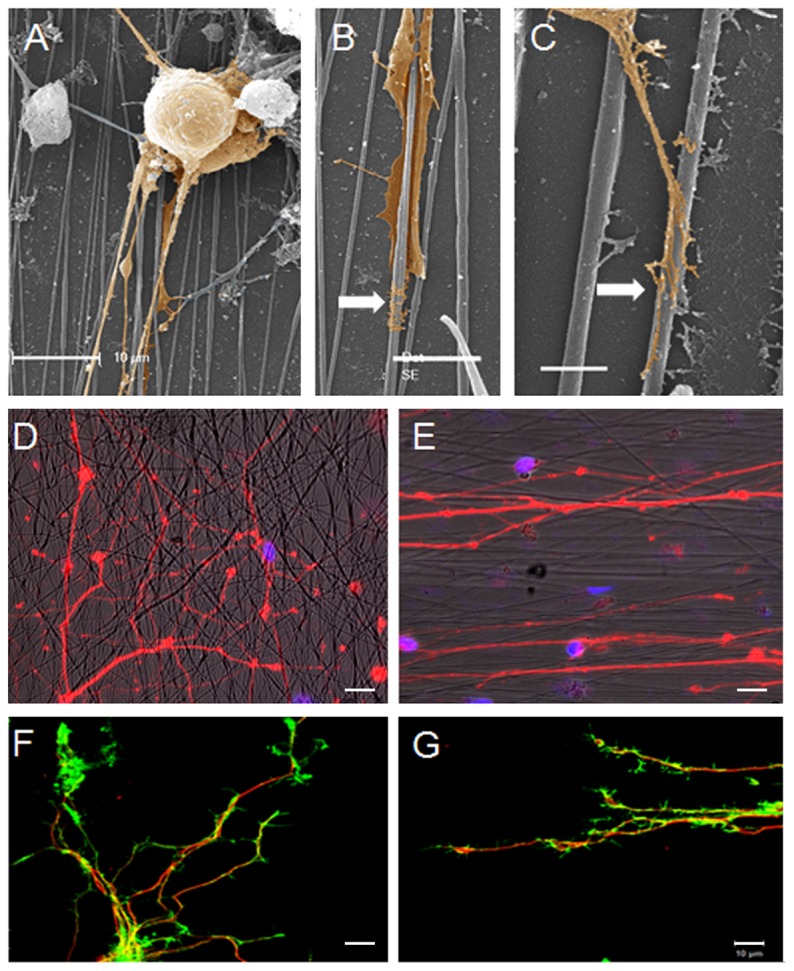
DRG neurons adhesion and growth on electrospun fibroin nanofibers.SEM observation of DRG cells adhering on nanofibers (A) and establishing tight contact (B and C). BIII tubulin staining of neurons growing on random (D) and aligned (E) nanofibers. BIII tubulin (red) and actin (green) of neuron growth cones on random (F) and aligned (G) nanofibers. Image acquisition performed after 5 days of culture. Scale bars: A 10µm, B 5µm, C 2µm, D, E, F and G 10µm. Images A, B and C have been recolored for sake of clarity.